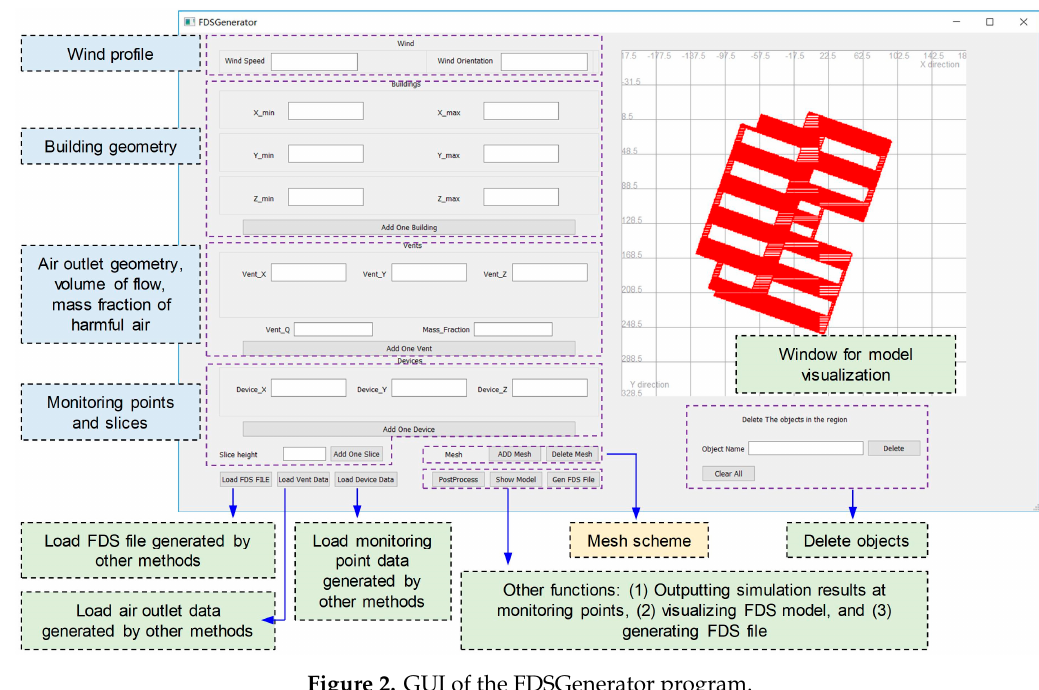
Figure 2. GUI of the FDSGenerator program.